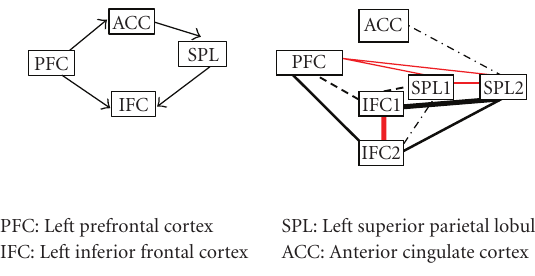
Figure 4: The network and results for Kondo et